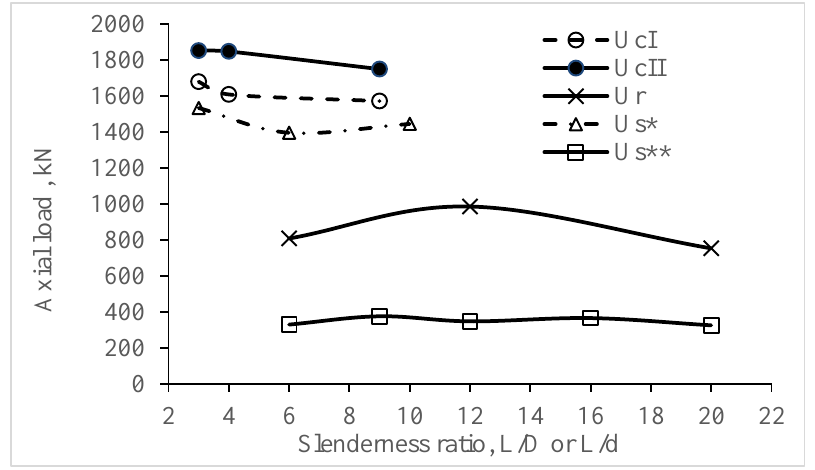
Figure 6. Axial load capacity of CFST columns and effect of slenderness.